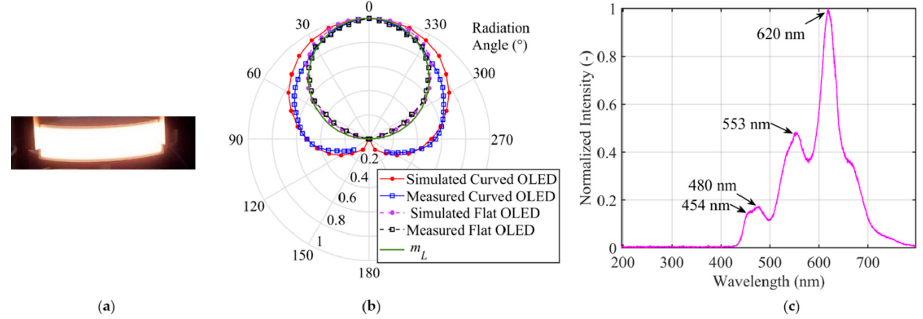
Figure 1. The flexible organic light emitting diodes (OLED) panel and its characteristics adopted in the simulation: ( a ) photograph, ( b ) the emission pattern of light source modeled for a flat and curved OLED, which is closely matched with the measured data, and ( c ) the normalized optical spectrum where the peak wavelengths are marked.